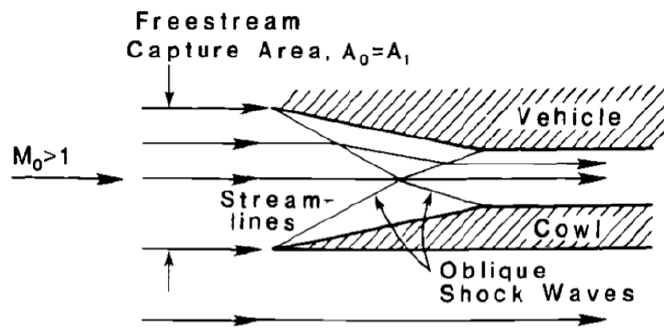
Figure 2. ( a ) External compression system and ( b ) combined external and internal compression system.